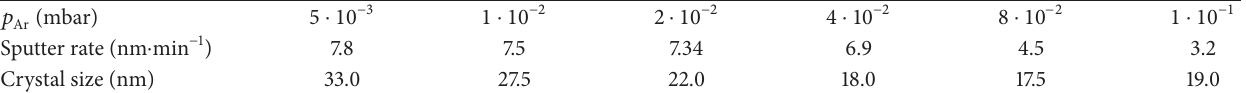
Table 2: Dependence of deposition rate and crystallite size on the pressure.